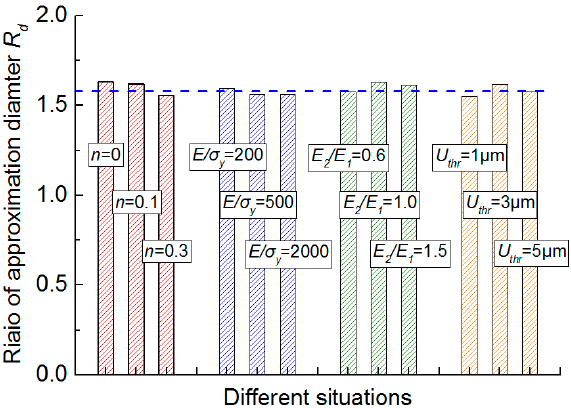
Figure 11. Influence of the strain hardening exponent, yield strain, elastic anisotropy, and the selected displacement threshold value on the diameter ratio, R d of the two approximation circles.